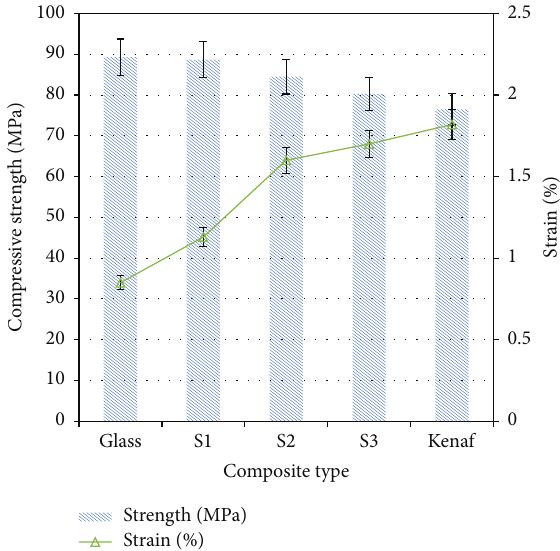
Figure 5: Compressive strength and strain of